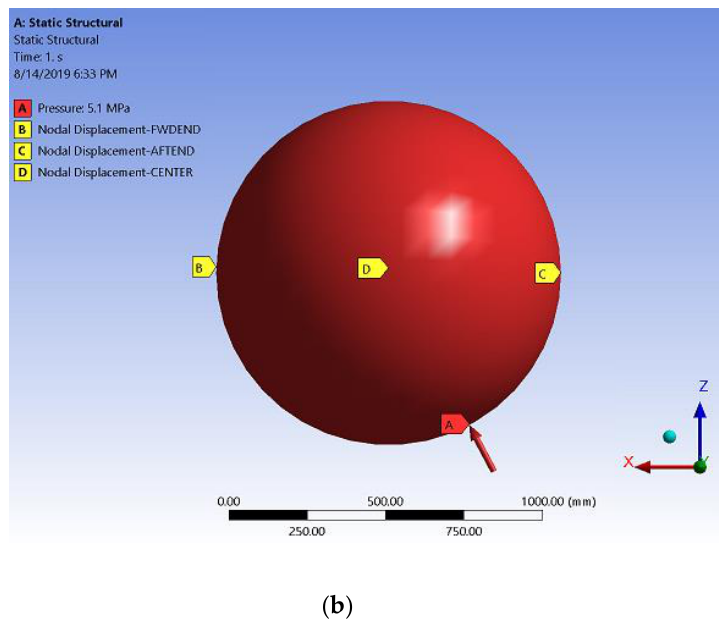
Table 2. Properties of Titanium alloy (Ti-6Al-4V). Young’s Modulus E (MPa)